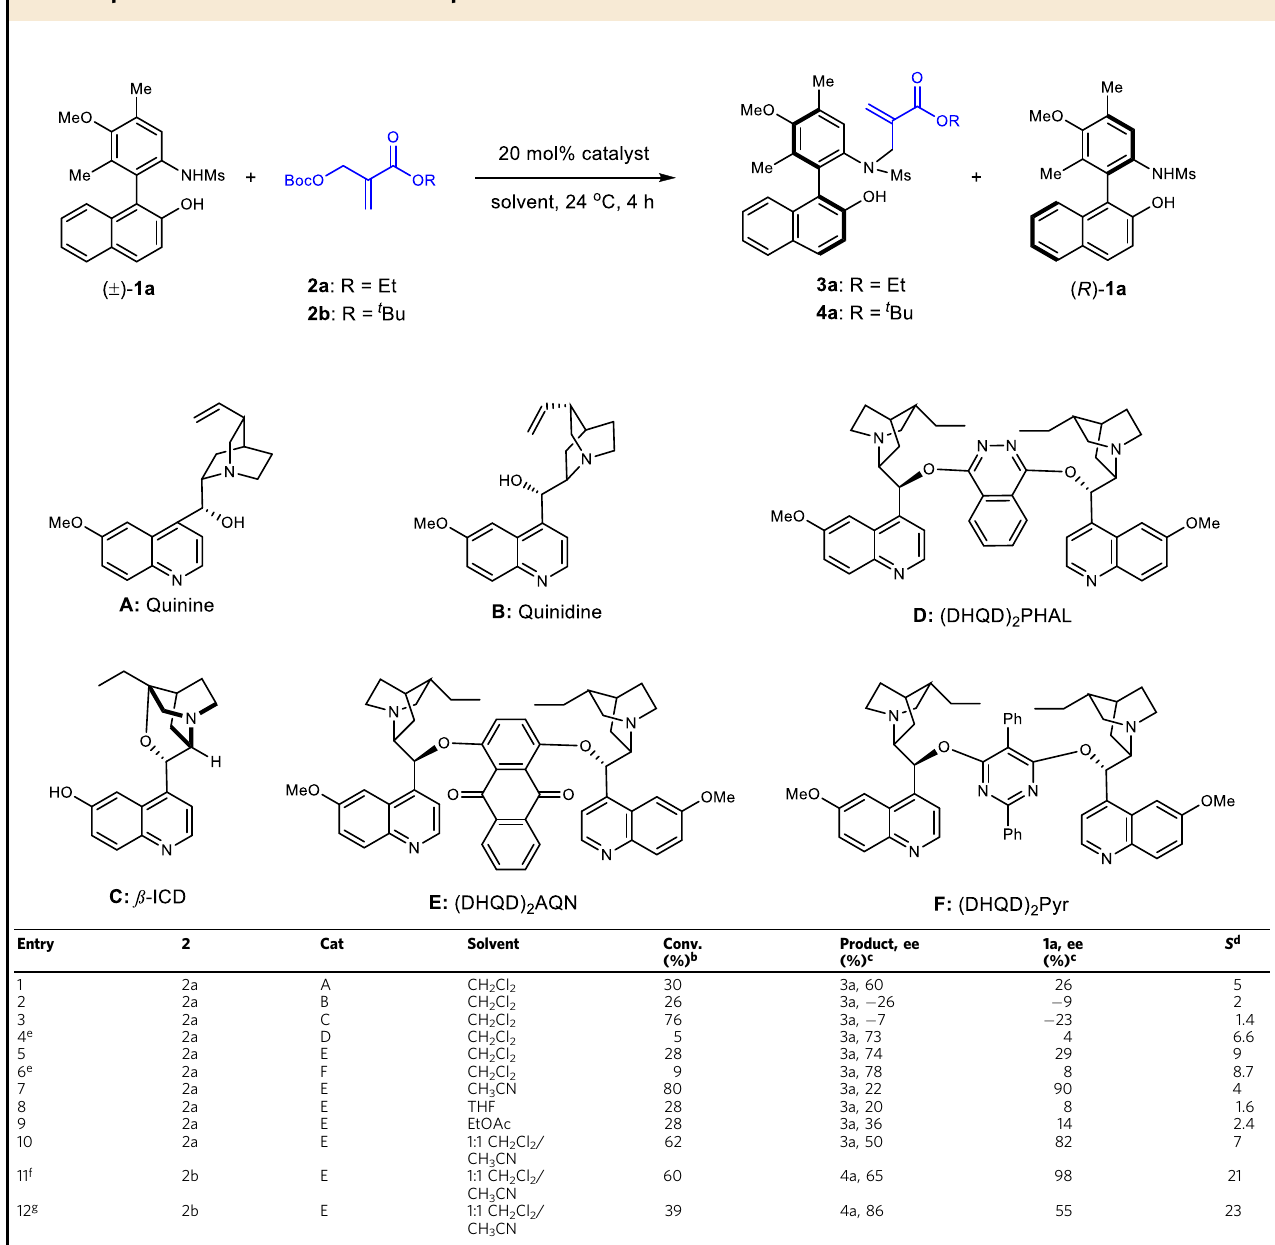
Table 1 Optimization of resolution of amino phenol 1